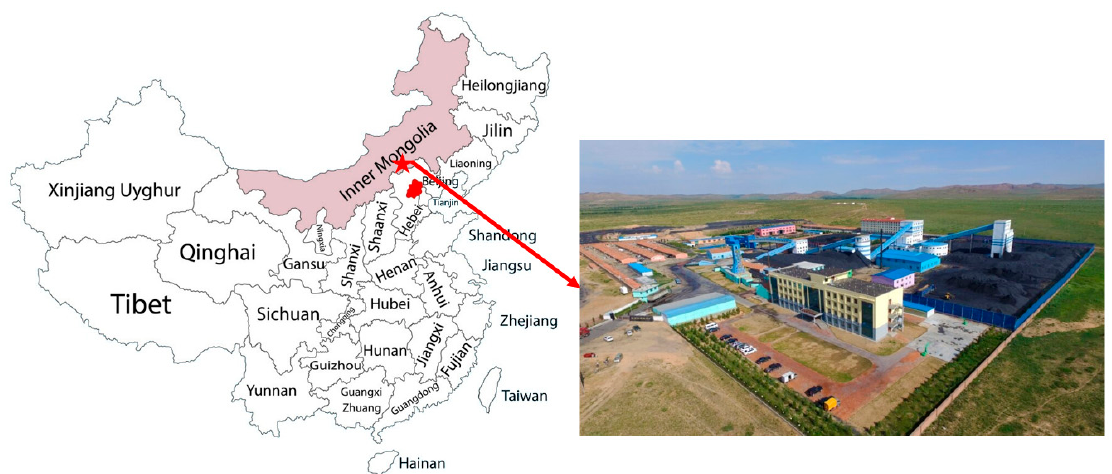
Figure 5. Location and appearance of the test mine.